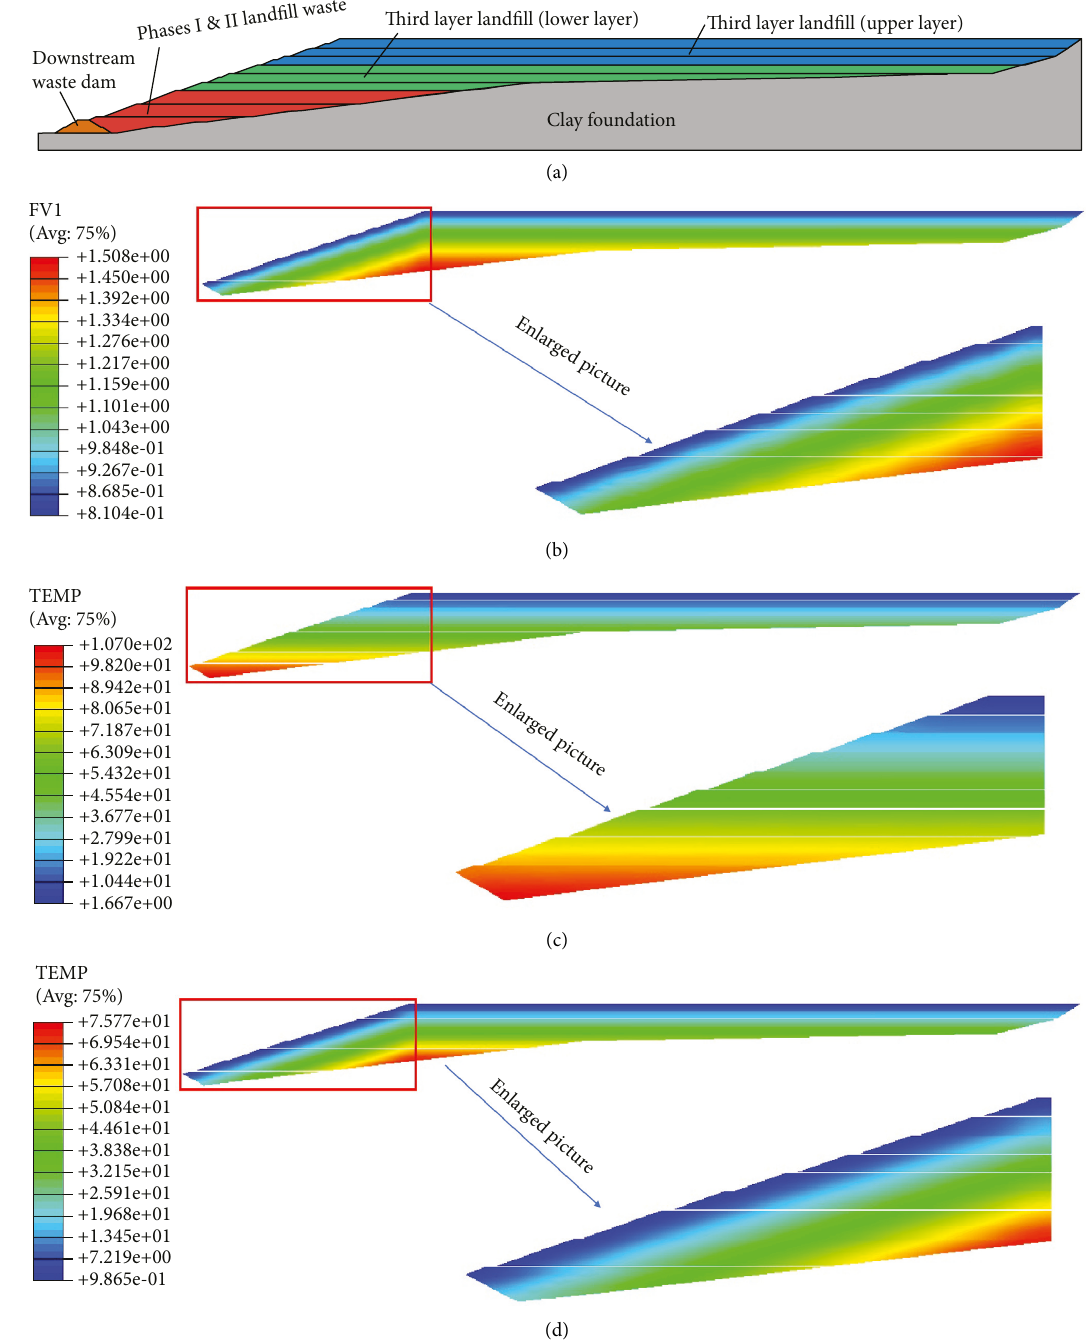
Figure 5: (a) Two-dimensional model of the landfill site. (b) Distribution cloud chart of waste unit weight (unit: × 10kN/m 3 ). (c) Simulated cloud chart of buried depth in Scheme 3-1 and Scheme 4-1 (m). (d) Simulated cloud chart of buried depth in Scheme 3-2 and Scheme 4-2